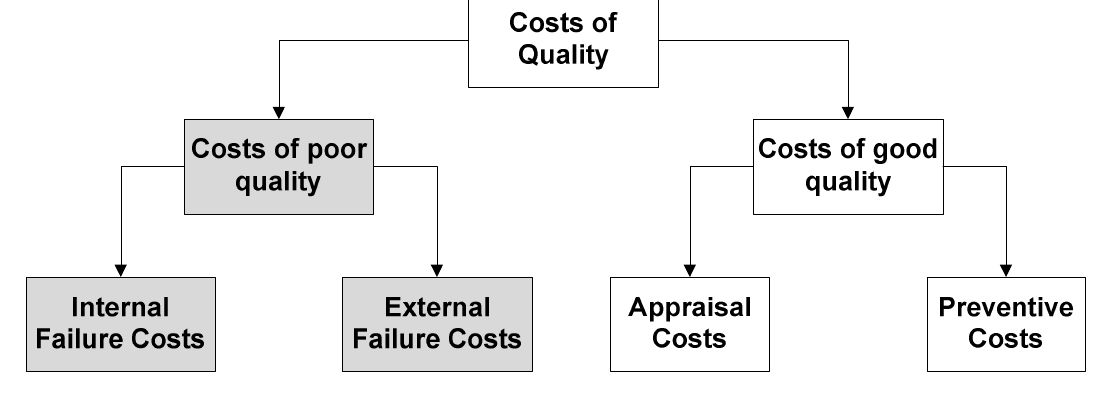
Figure 3 – Costs of quality structure (PAF